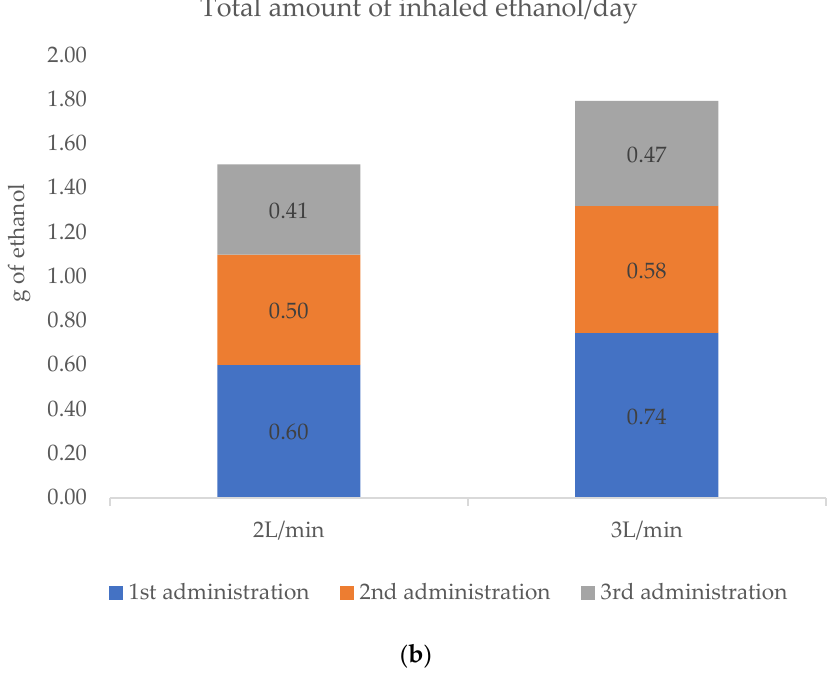
Figure 3. ( a ) The total amount of ethanol evaporated from the initial solution, according to GC-MS data determined by calculation of the areas under concentration-time curves (AUC), and ( b ) the estimated total amount of ethanol inhaled by human adults taking into account the recommended short-term exposure values for inhalation, in sedentary or passive activity ( b ), after the 45 min of treatment at 2 L/min and 3